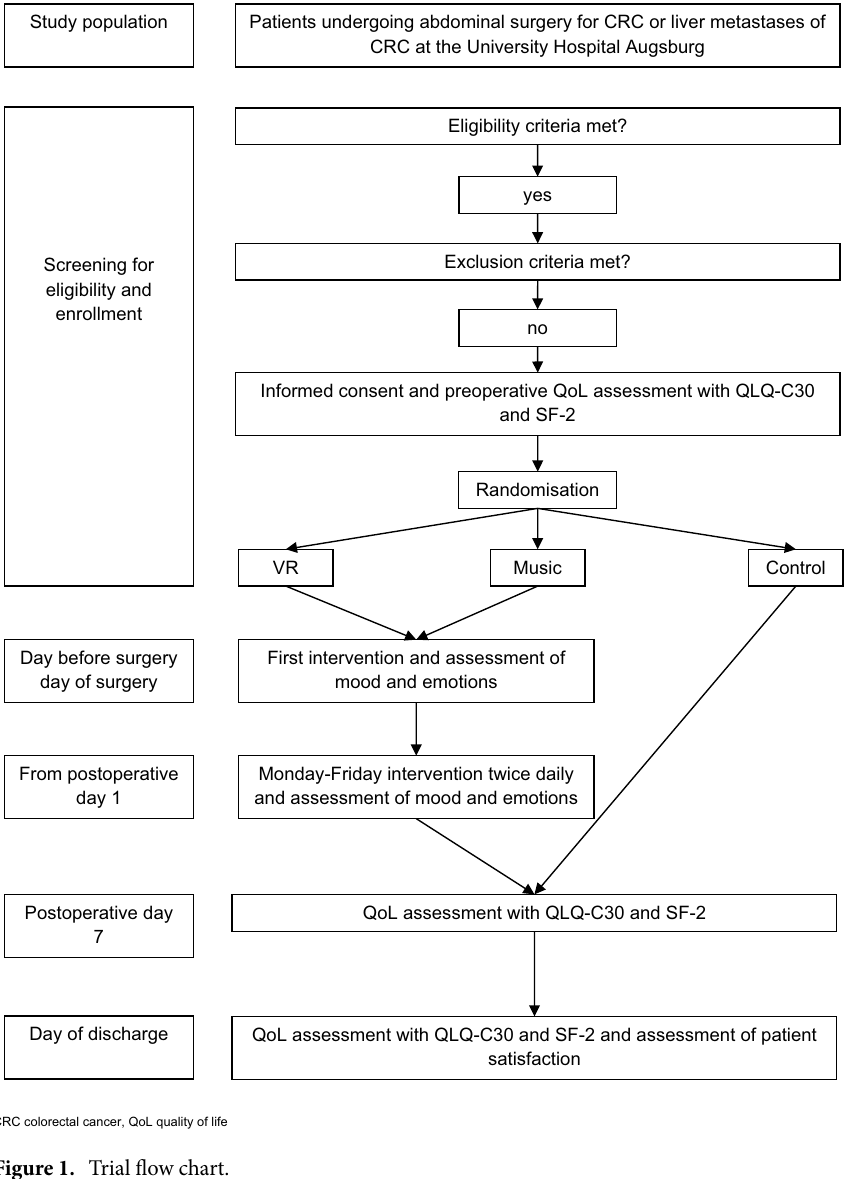
Figure 1. Trial flow